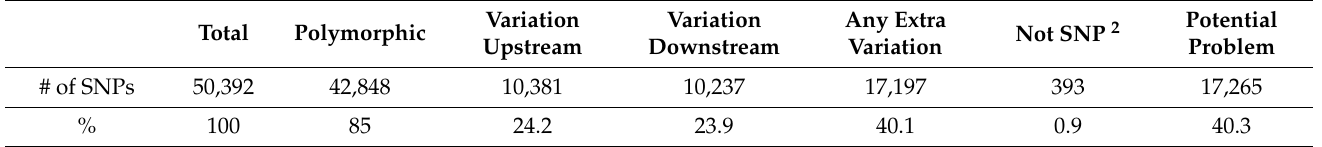
Table 2. BeadChip SNPs with additional variation within the probe target sequence 1